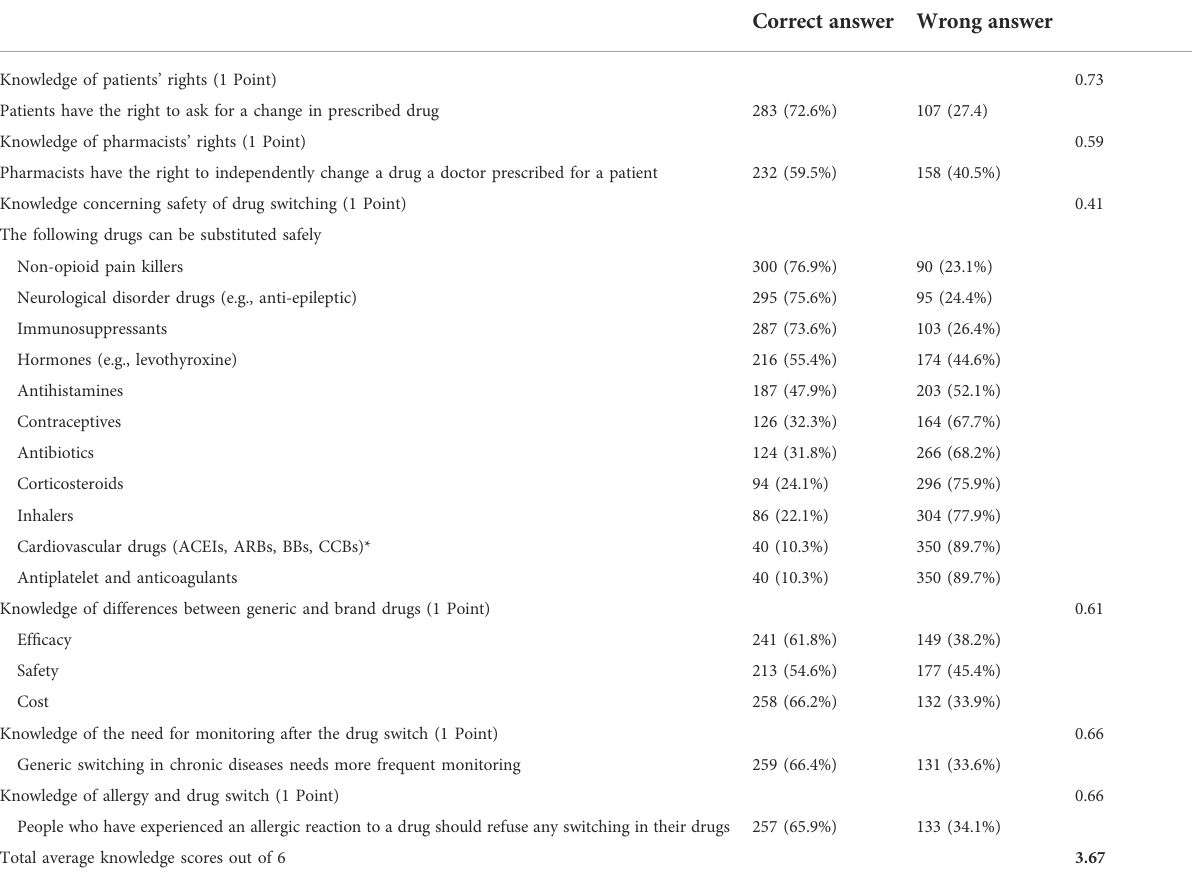
TABLE 3 Evaluation of knowledge on different aspects of the generic switching process, N =